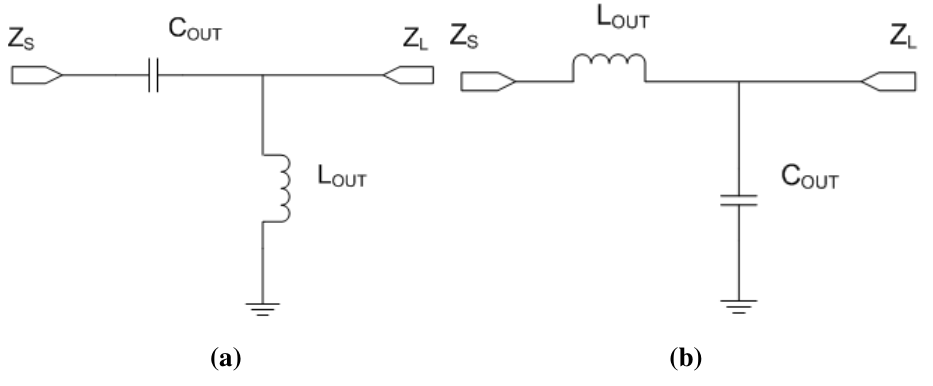
Figure 23. Two possible output matching